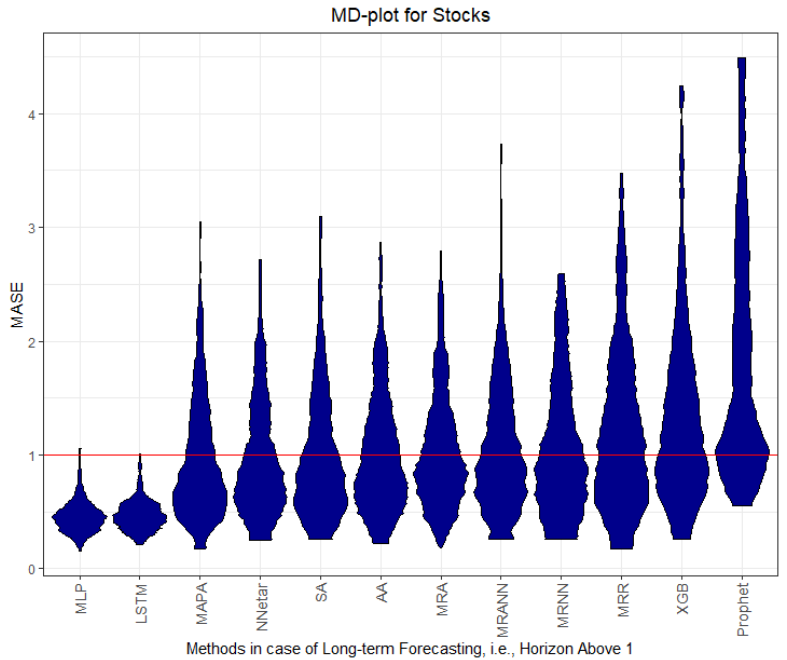
Figure 8. Mirrored density plot of Mean Absolute Scaled Errors (MASE) computed with a rolling forecasting origin over all horizons on dataset